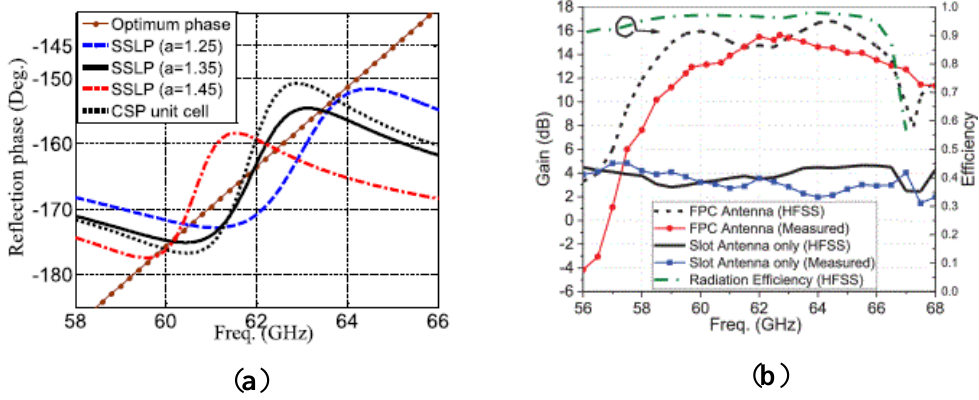
Figure 2. ( a ) Reflection phase of the PRS unit cell; ( b ) Measured and simulated gain and efficiency of the RCA in